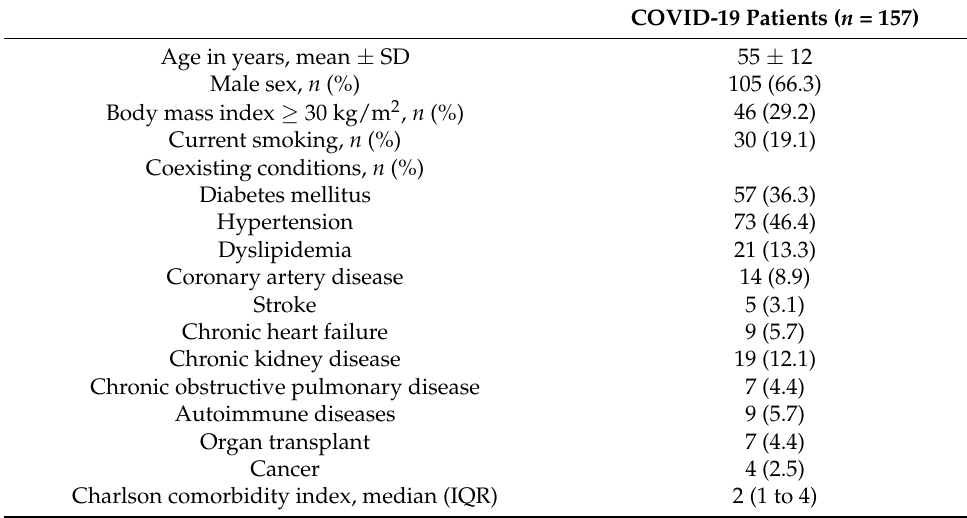
Table 1. Demographic and clinical data of study